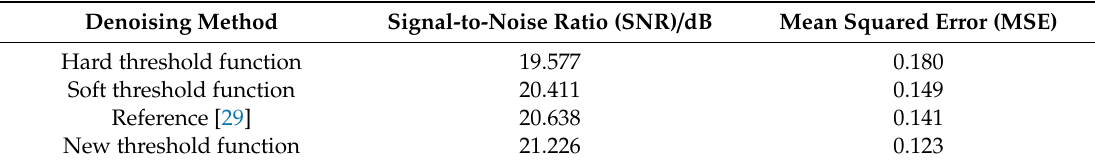
Figure 5. The comparison of noise reduction results in simulation. ( a ) Data after noise reduction by soft threshold function; ( b ) data after noise reduction by hard threshold function; ( c ) data after noise reduction in reference [29] function; ( d ) data after noise reduction by new threshold function. To compare the denoising effects of traditional soft and hard threshold functions and the aforementioned two threshold functions accurately, unified objective evaluation criteria should be introduced. Two evaluation indicators SNR and MSE for the denoising performance were used for a quantitative analysis of the denoising effects. The definitions are as follows: the higher the SNR of point cloud data with denoising completed and the smaller the MSE, the more approximate the post-denoising data is to the original data and, meanwhile, the denoising effect is better. The unit of SNR is dB. The concrete values of evaluation criteria for the four threshold functions after denoising are listed in Table 2.